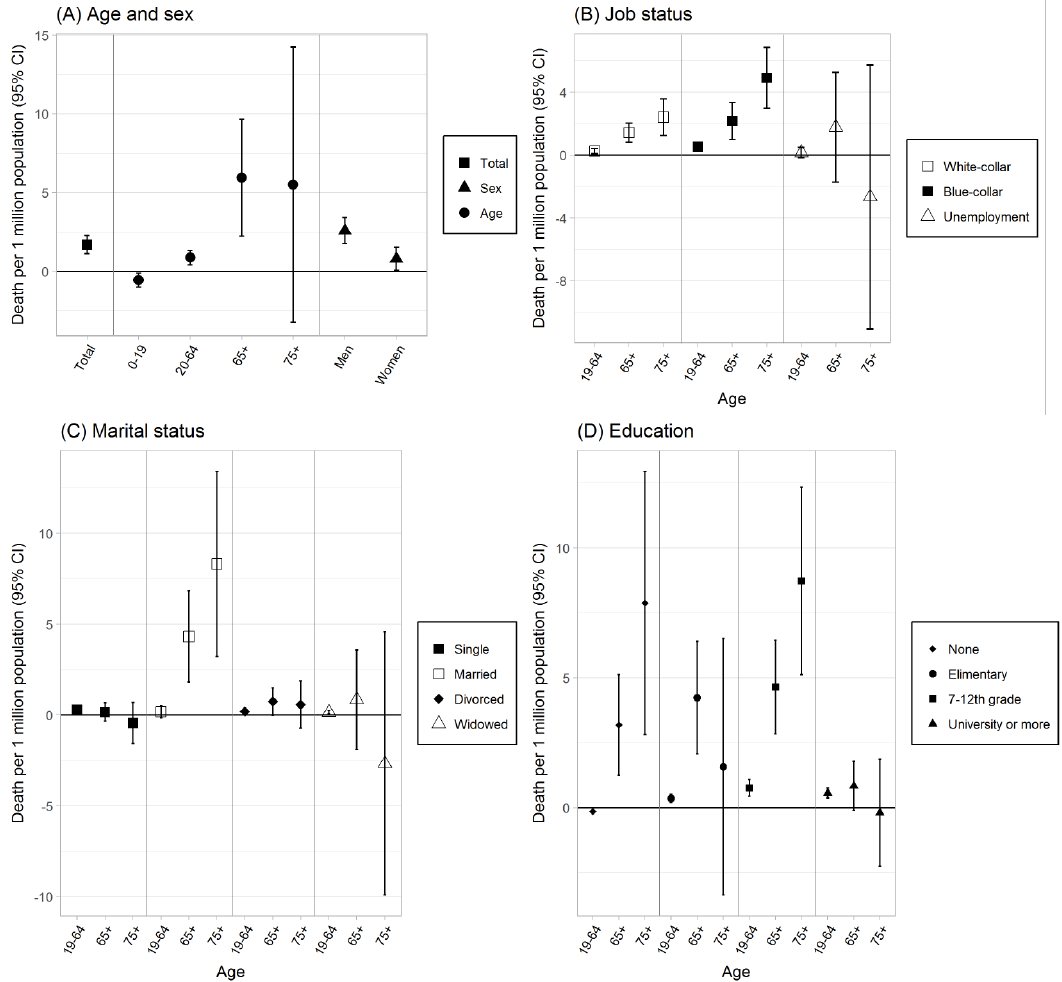
Figure 2. Effects of the heat wave warning system on all-cause mortality based on the comparison of mortality changes due to heat wave alert announcements for heat wave days versus non-heat wave days (i.e., counter factual) in 2009 – 2014 (mortality per 1,000,000 people per day). The effects are the estimates of difference-in-differences (DD) that were obtained by comparing mortality due to heat wave alert announcements for heat wave days versus mortality for non-heat wave days (i.e., counterfactual) through the difference-in-differences analysis. Negative estimates indicate reduction in mortality due to the heat wave alerts.